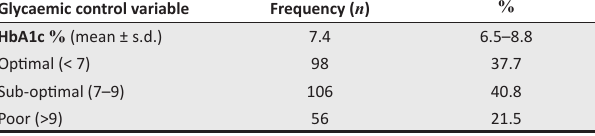
TABLE 3: Glycaemic control of study participants.